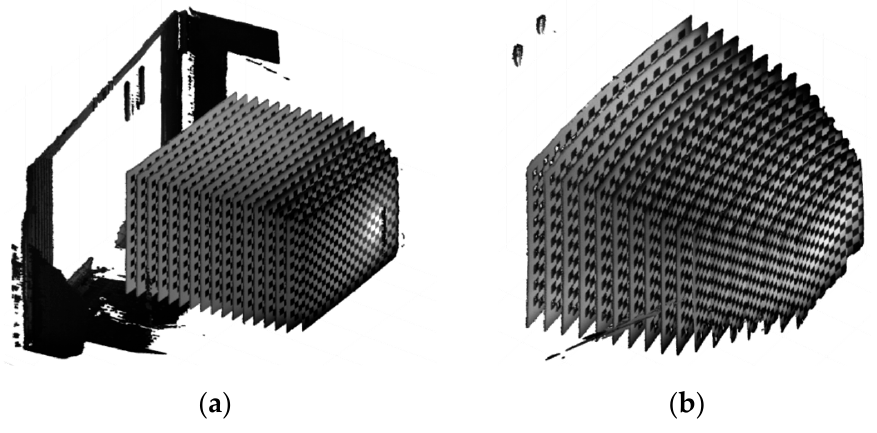
Figure 18. Obtained 3d point cloud: ( a ) in air; ( b ) in water.